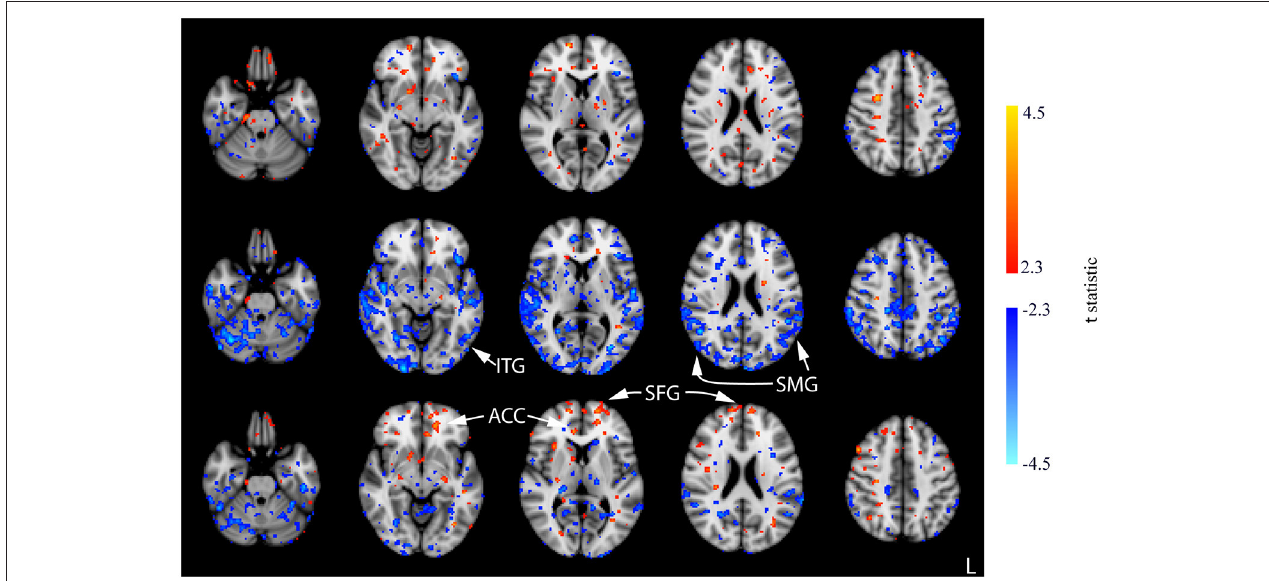
FIGURE 8 | Results of the one-way ANOVA for the ACT 1mA group displayed through post-hoc , pairwise comparisons between session 1 pre-stimulation and session 1 post-stimulation (top row), session 2 post-stimulation (middle row), and session 3 post-stimulation (bottom row). Corresponding images demonstrating the magnitude of CBF changes are given in Supplementary Figure 4 . Axial slices are taken from MNI coordinates z = − 26, − 8, 6, 22, and 44mm (left to right).